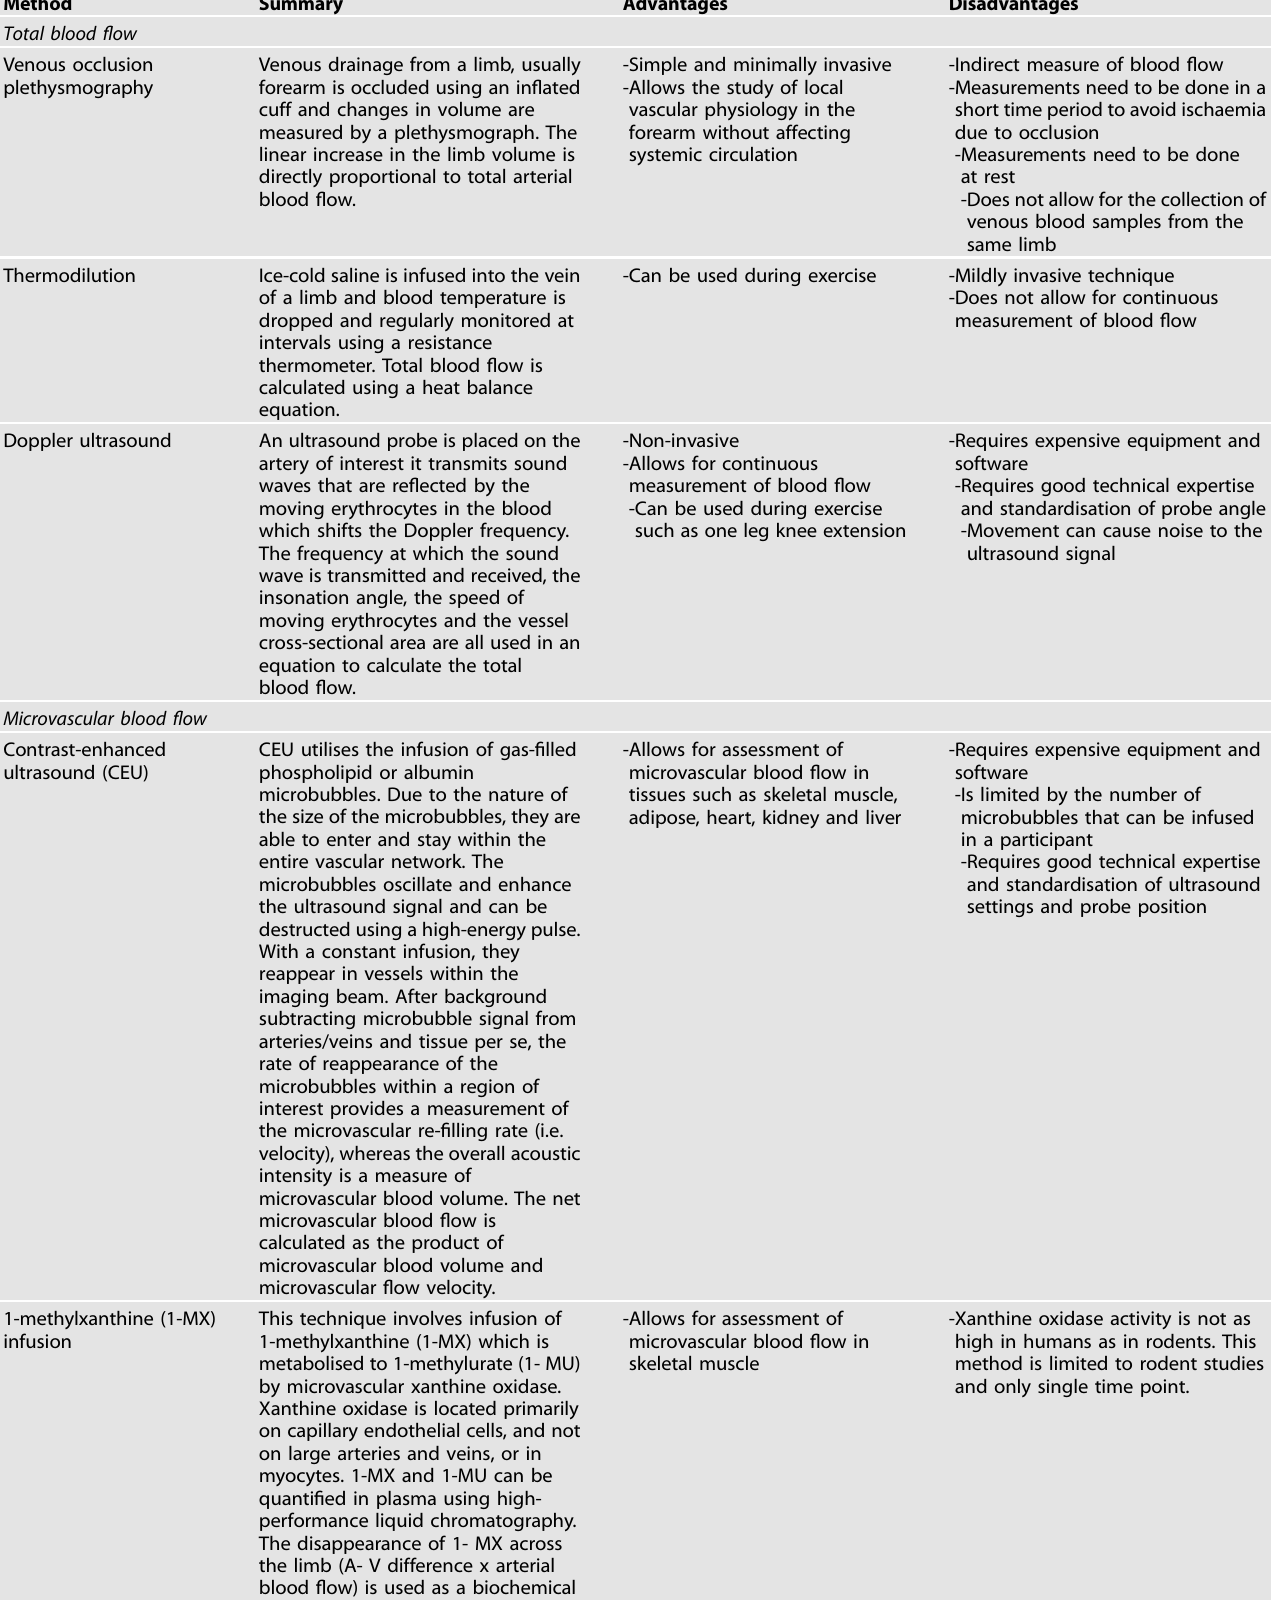
Table 1. Methods for measurements of blood fl